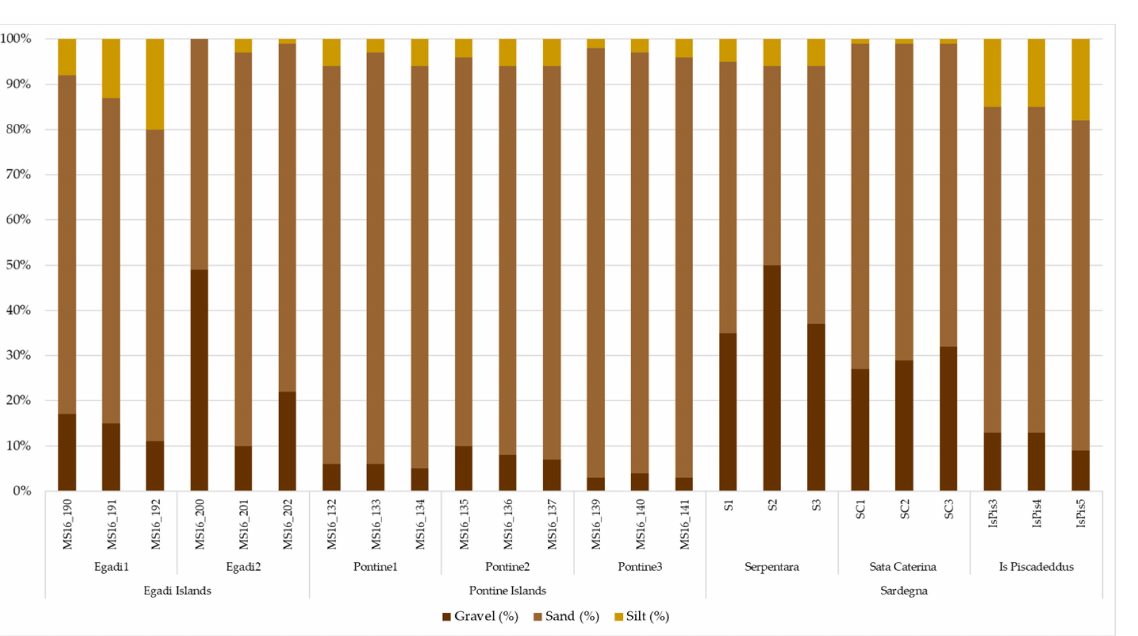
Figure 6. Bar graph with the grain size percentage per station and